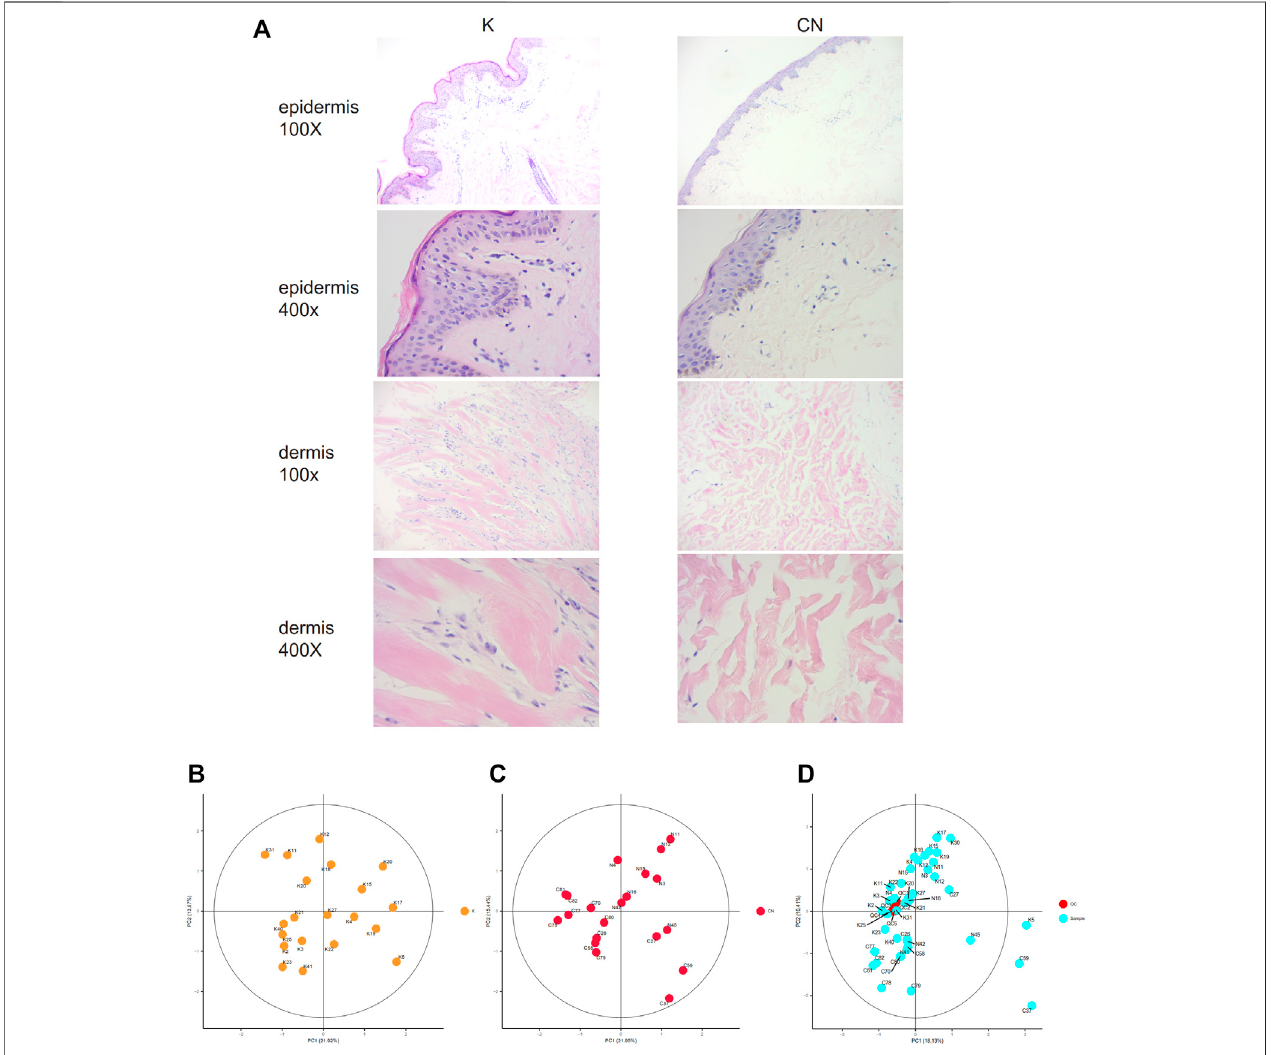
FIGURE 1 | (A) Histological images of the K group and control group, 100X. 400X. (B) Unsupervised principal component analysis (PCA) of keloid tissues. Each pointinthe fi gurerepresentsasample,andthepositionofthepointinthe fi gureisdeterminedbyallthemetabolitesinthesample.Theellipseinthe fi gureisbasedonthe 95% con fi dence interval calculated and drawn by Hotelling T2. The sample falling outside the ellipse implies that the point may be an outlier. (C) Unsupervised principal component analysis(PCA) ofcontroltissues. (D) Calibration signal drift.QCsamplepointstogether,provingthatthecalibrationeffectisgood. ThereddotsareQC samples after calibration, and the blue dots are test